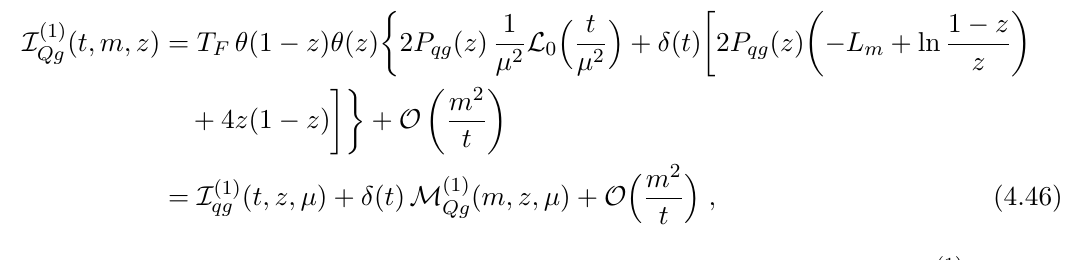
0 limit as a function of p t !